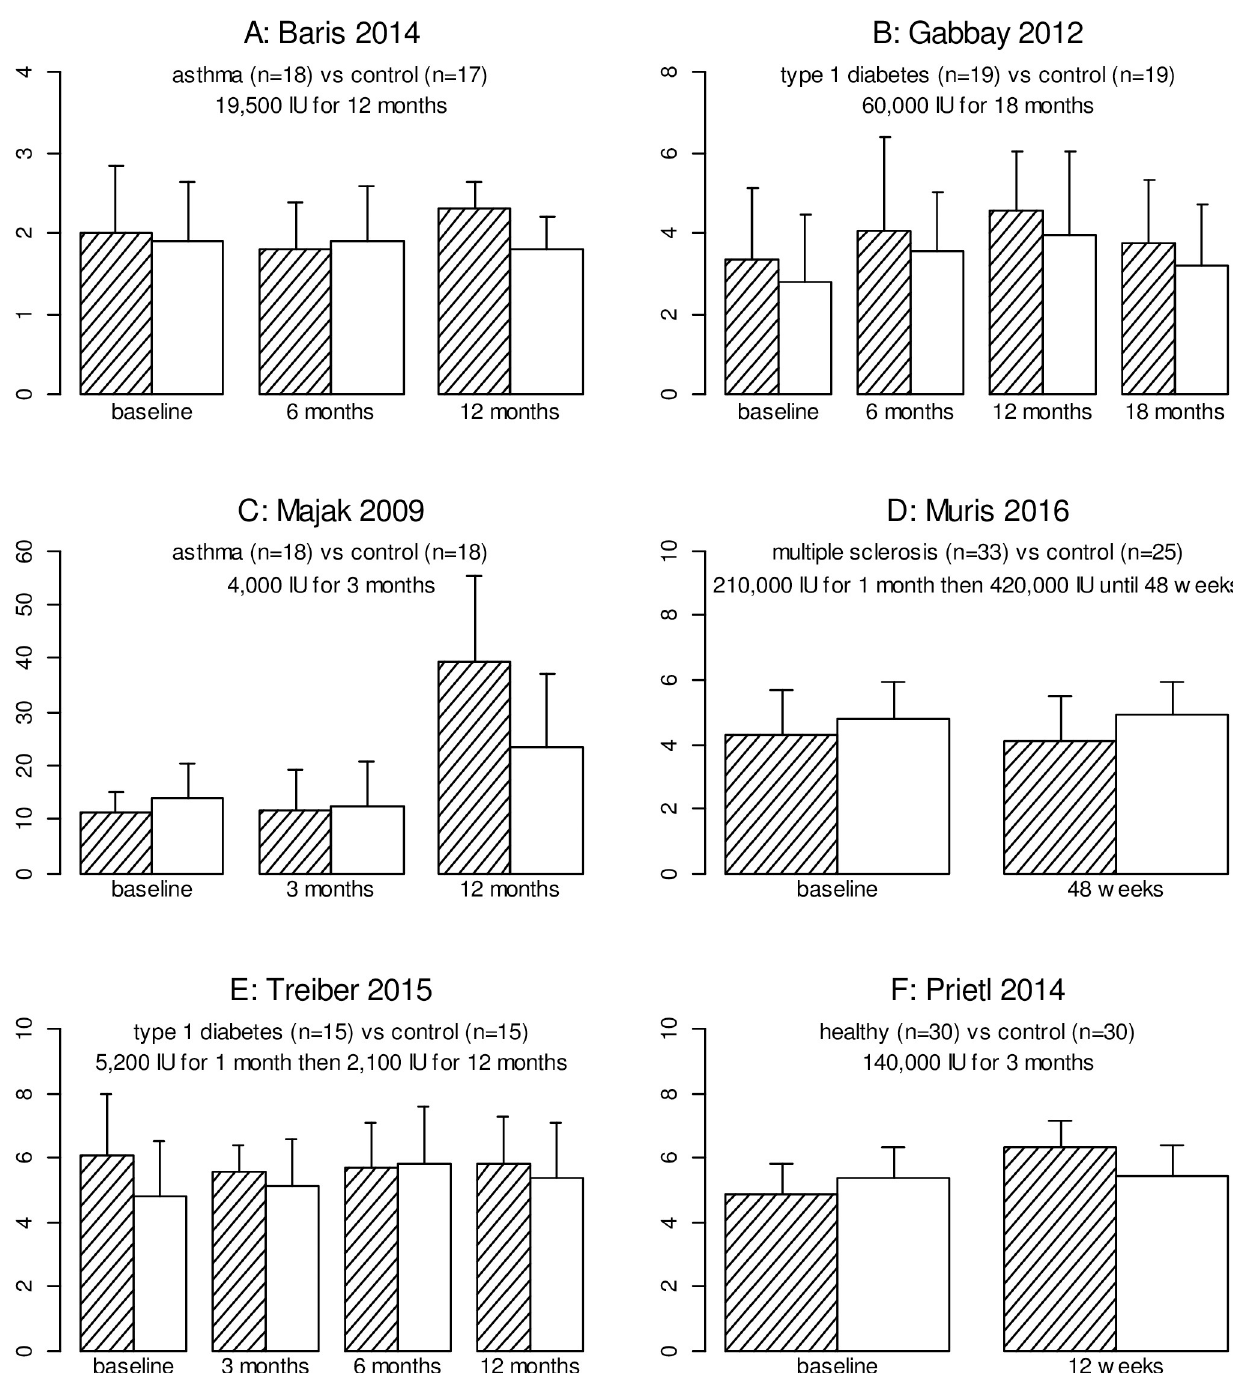
Fig 3. Mean % Tregs in subjects who received vitamin D (shaded bars) compared with those who received no vitamin D (unshaded bars), shown at timepoints measured in each study. Error bars show standard deviation. The percentage of Tregs is defined as (A, B) % CD4+CD25+ Foxp3+ in peripheral blood, (C) % CD4+CD25+ Foxp3+ in CD4+CD25+ cells, (D) CD4+CD25+ CD127negFoxp3+ in CD4+ cells, (E) % CD4+CD25hi FoxP3 + CD127low in CD4+ cells, (F) % CD4+CD25hi FoxP3+ CD127dim in CD4+ cells. The number randomised to each trial arm and the monthly equivalent doses of vitamin D in the treatment arm are